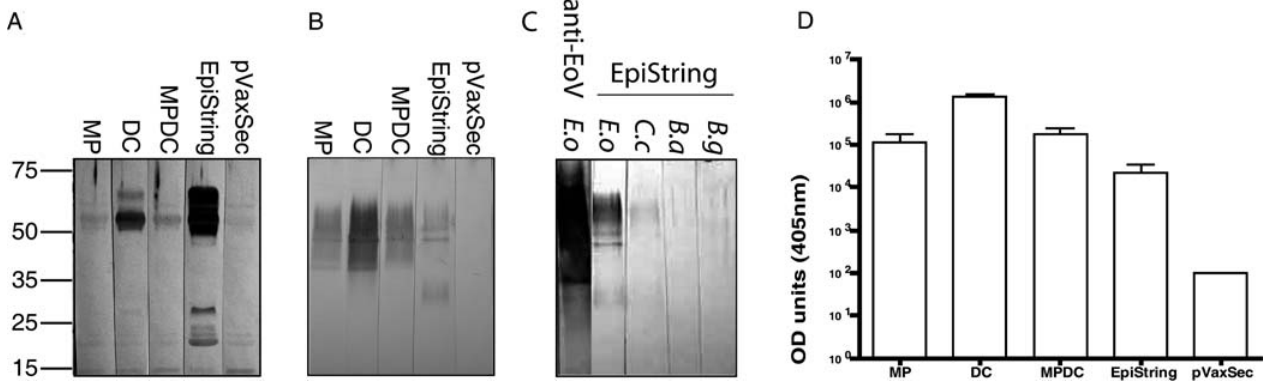
Figure 4. EoSVMP String Antiserum Recognizes Multiple SVMP Isoforms (A and B) Comparative reactivity on immunoblots using pooled murine antisera raised against EOC00024 domains (MP, DC, and MPDC) and EoSVMP string to E. ocellatus venom under reduced SDS-PAGE (A) and native PAGE (B) conditions. (C) Comparative reactivity on native PAGE immunoblots of EoSVMP string antiserum to venoms from E. ocellatus (Eo), C. cerastes (Cc), B. arietans (Ba), and B. gabonica (Bg). Cross-reactivity of rabbit antisera against E. ocellatus venom (anti-EoV) is shown for comparison. (D) IgG ELISA end-point titres determined by serial dilution of murine antisera. Values represent the mean dilution ( 6 standard error of the mean) of sera equaling the titre of sera from unimmunized BALB/c mice. DOI: